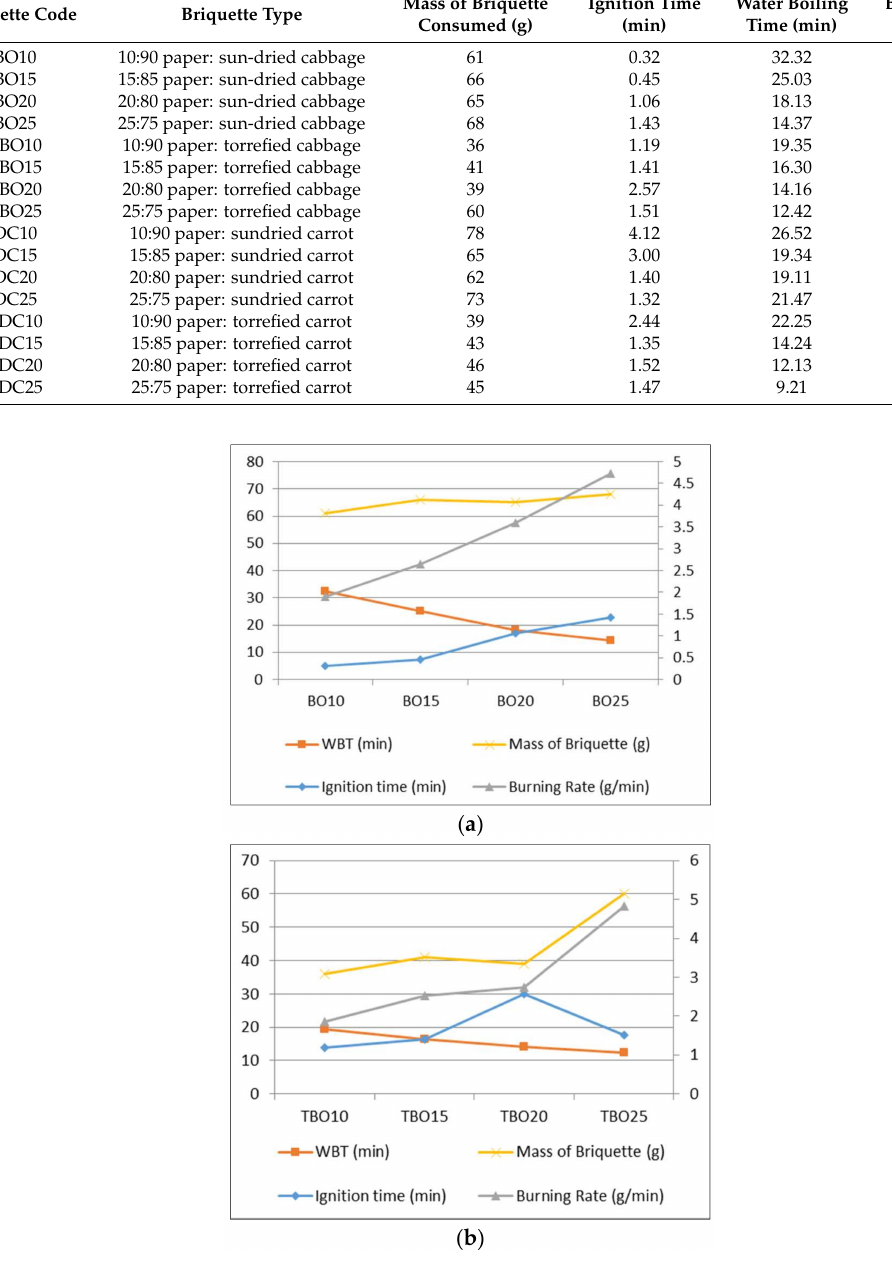
Figure 5. Thermal characteristics of ( a ) sun-dried and ( b ) torrefied cabbage